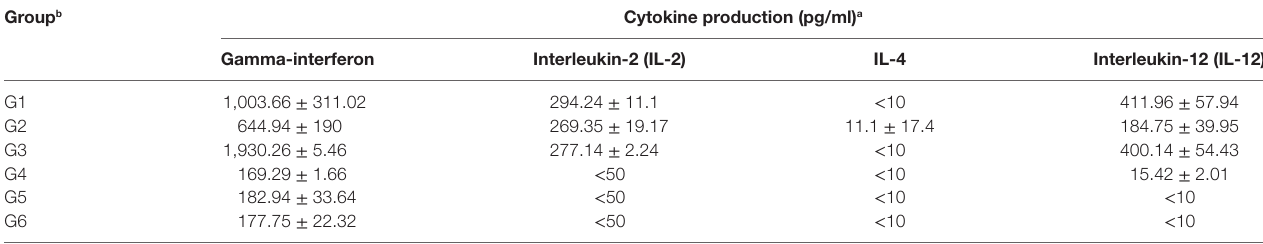
TaBle 3 | Cytokine production by splenocytes of immunized Kunming mice after stimulation by T. gondii lysate